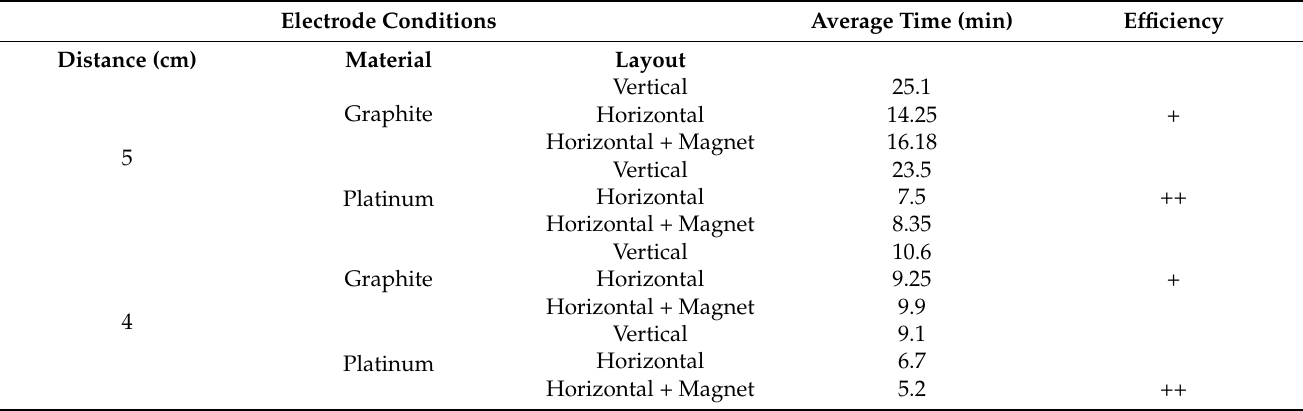
Table 1. Summary of the optimal hydrogen production efficiency for various electrode and magnet